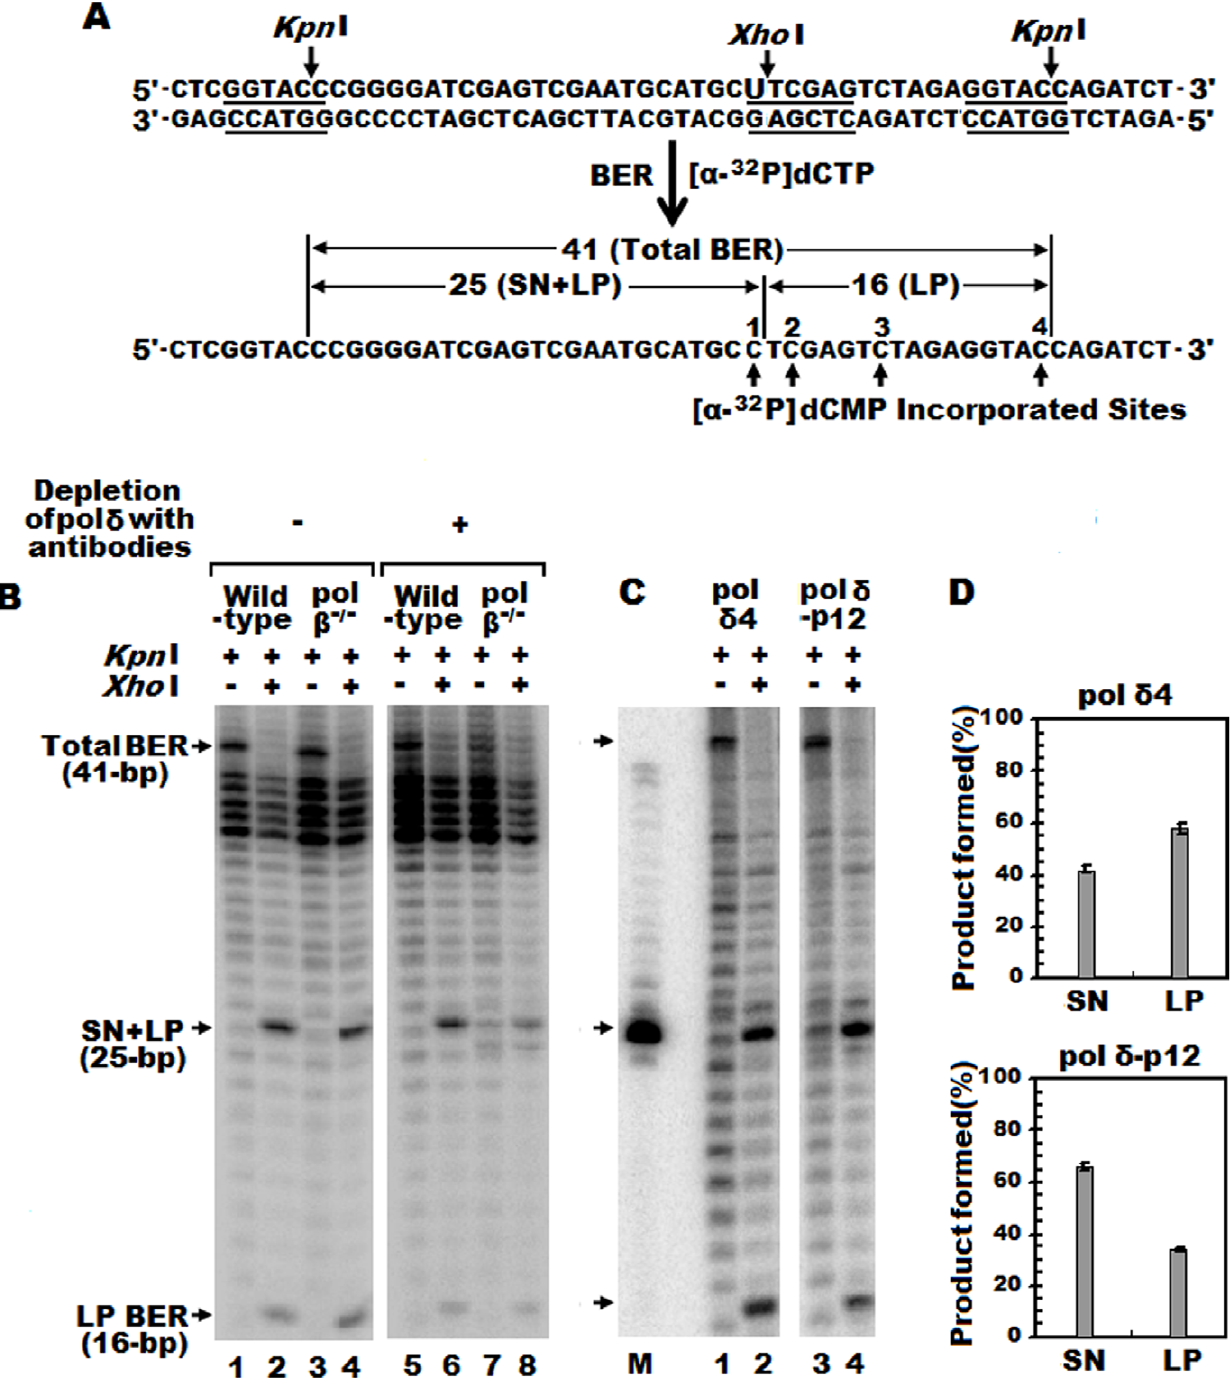
Figure 8. Contribution of pol d to SN and LP BER of uracil-containing plasmid DNA. Panel A: A schematic representation of the uracil- containing plasmid DNA with Kpn I and Xho I restriction-enzyme sites (underlined). After BER reaction, the repaired products were restricted with indicated enzymes, and digested DNA fragments were separated on 16% denaturing polyacrylamide gel containing 8 M urea. DNA fragment sizes and descriptions of DNA synthesis products are indicated. Panel B and C: Autoradiograph of gel electrophoresis to measure in vitro BER products. The BER reaction was performed with cellular extracts (B), from wild-type MEF (lane 1, 2), pol b 2 / 2 (lane 3, 4) cells, pol d –depleted wild-type MEF (lane 5, 6), and pol d –depleted pol b 2 / 2 (lane 7, 8). The BER reaction was performed with purified enzymes (C), pol d 4 (lane 1, 2) and pol d 3-p12 (lane 3, 4). Lane M indicates a 32 P labeled 25-bp oligonucleotide as a DNA maker. Panel D: The ratio of SN BER and LP BER with purified pol d 4 (upper panel) and pol d 3-p12 (lower panel). The amount of the SN BER product was calculated by subtracting the radioactivity of the 16-bp fragment from that of the 25-bp fragment.